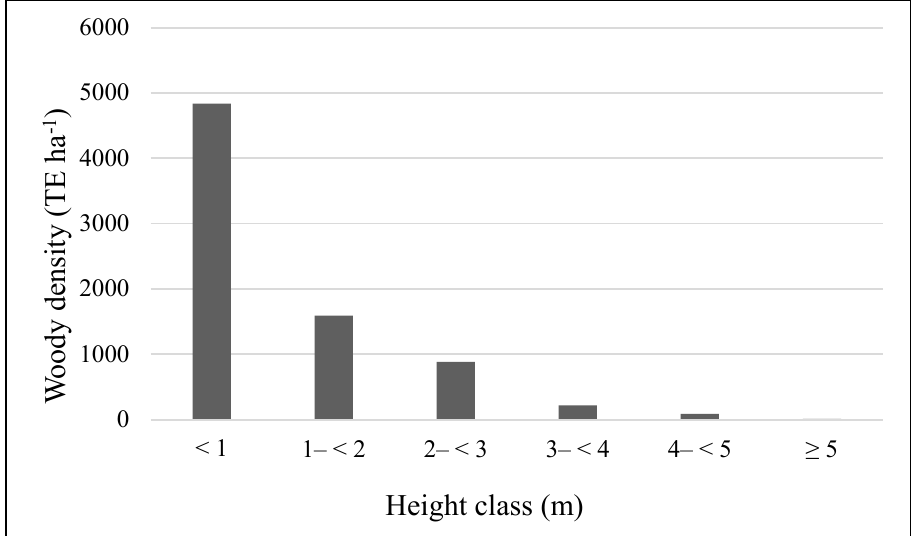
Figure 3. Combined mean density of all woody species in different height classes in the whole study area.